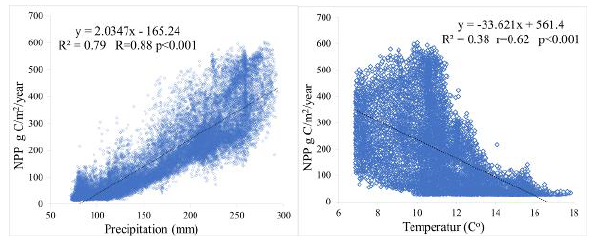
Figure 7. Correlation between average growing season NPP a) precipitation, b) temperature during 1982-2015. NPP was positively correlated with air temperature west and east of Lake Hovsgol (r=0.2-0.4, p<0.01), eastern part of the Selenge river (r=0.2, p<0.01), and center part of the Dornod province in Mongolia (r=0.2-0.4) (Figure 8b). NPP value decrease gradually shift down to southwards of Mongolia. That kind of decline pattern is heavily influenced by terrestrial landscape (concave and convex landforms), which limits precipitation distribution, on the other hand, dominant steppe and deserts areas in south and south-west create the vegetative cover and precipitation sparse and